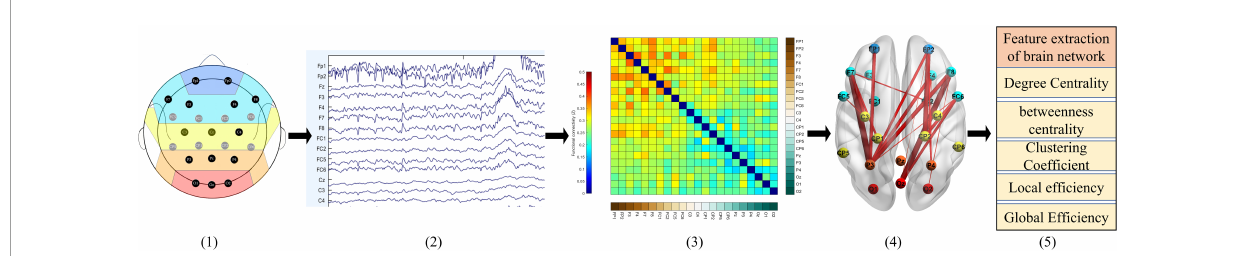
FIGURE3 Typical construction process of functional brain network. From left to right : (1) the electrode of interest; (2) the preprocessed EEG; (3) the connection matrix calculated by PLI; (4) sparsely processed and mapped to the 3D human brain model; (5) carry out feature analysis on the sparse brain network.